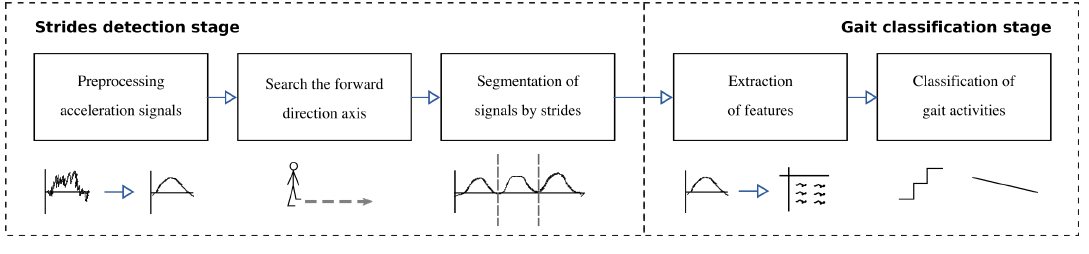
Figure 1. Proposed gait recognition method. This method is divided into two stages: (i) strides detection (steps 1–3) and (ii) gait classification (steps 4–5).